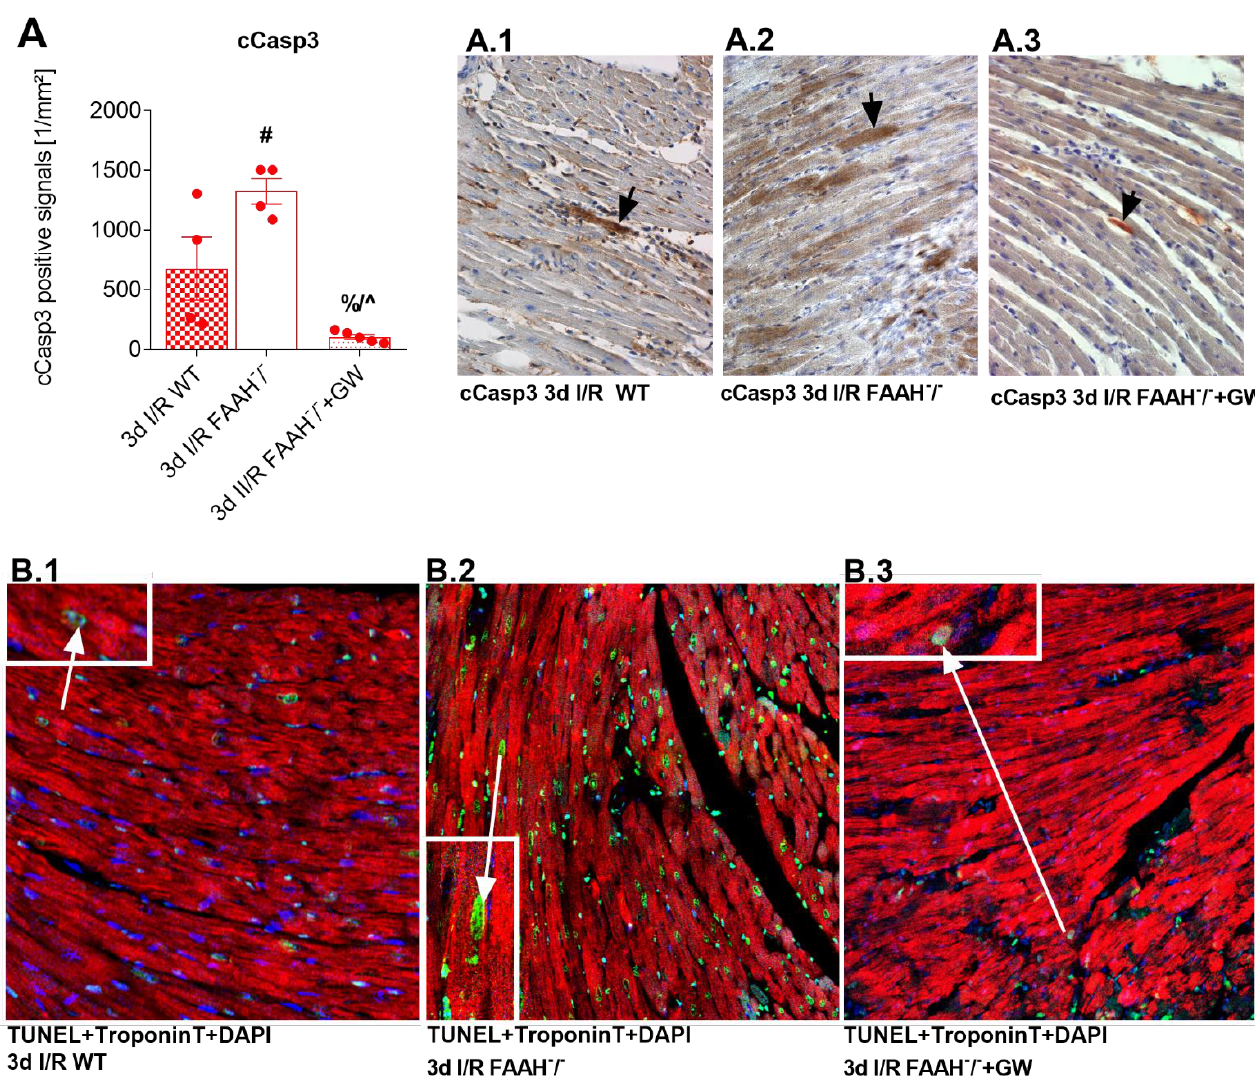
Figure 5. PPAR- α antagonists GW6471 decrease apoptosis and cardiomyocyte loss in FAAH − / − -mice. ( A ) Significantly more cCasp3 positive apoptotic cardiomyocytes were observed in FAAH − / − compared to WT- and GW6471 treated FAAH − / − animals. ( A1 – A.3 ) Representative stainings showing cCasp3 positive apoptotic cardiomyocytes (arrows). ( B.1 – B.3 ) Representative TUNEL + Troponin T + DAPI staining underline these findings; arrows indicate apoptotic, TUNEL positive cardiomyocytes. Insets with magnified details show cells of interest. Magnification in ( A1 – A.3 , B.1 – B.3 ): 400×. Insets: 800×. cCasp3, Cleaved caspase-3; DAPI, 4′,6 -diamidino-2-phenylindole; DMSO, Dimethyl sulfoxide; FAAH, fatty acid amide hydrolase; WT, wild-type; #, p < 0.05 FAAH − / − vs. WT; %, p < 0.05 FAAH − / − +GW vs. FAAH − / − +DMSO; ^, p < 0.05 FAAH − / − +DMSO vs. WT.